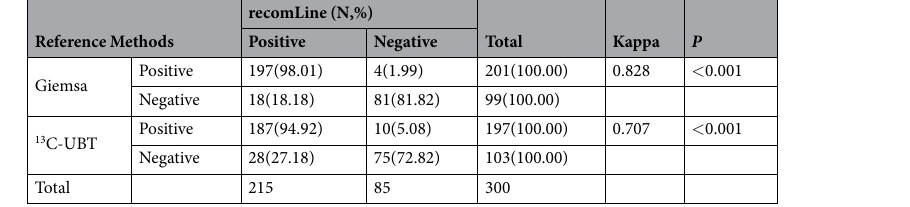
Table 4. Consistency of H.pylori test results among diagnostic